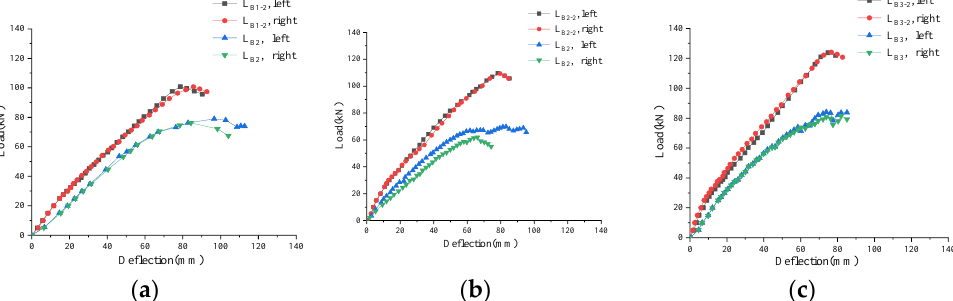
Figure 22. Load – displacement curve of group B. ( a ) 0 kN, 4 steel wires; ( b ) 7 kN, 4 steel wires; ( c ) 14 Figure 22. Load-displacement curve of group B (regulated beam). ( a ) 0 kN, 4 steel wires; ( b ) 7 kN, kN, 4 steel wires . 4 steel wires; ( c ) 14 kN, 4 steel